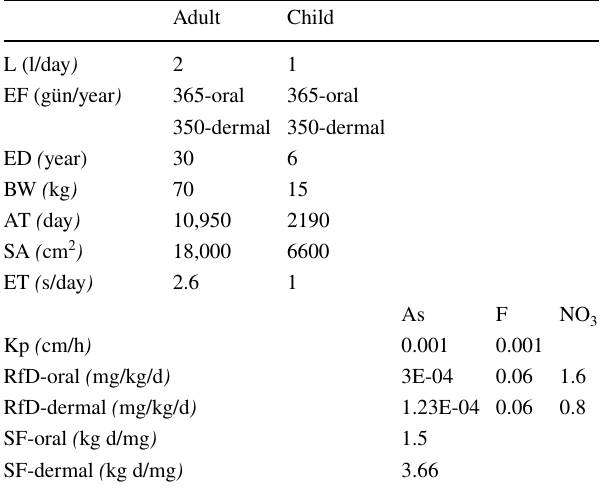
Table 7 Default values for drinking water and dermal use (USEPA, 2001) and Kp, RfD, SF values (IRIS, 2005; USEPA, 2013)